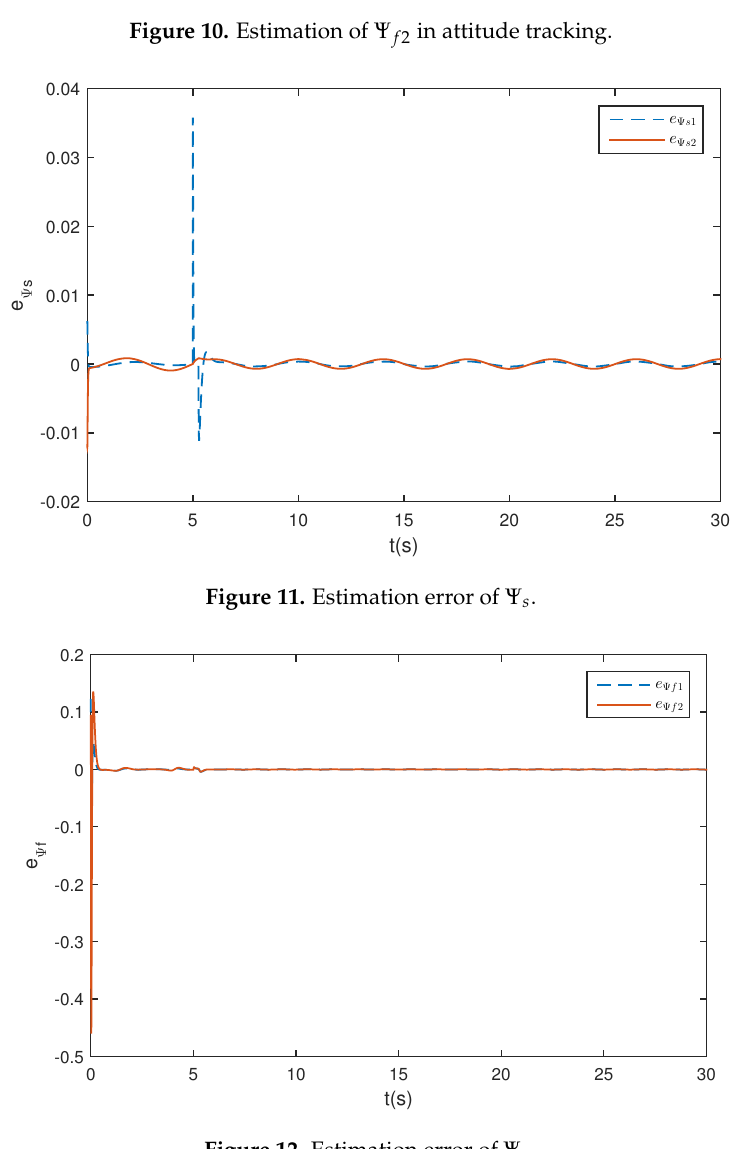
Figure 12. Estimation error of Ψ f